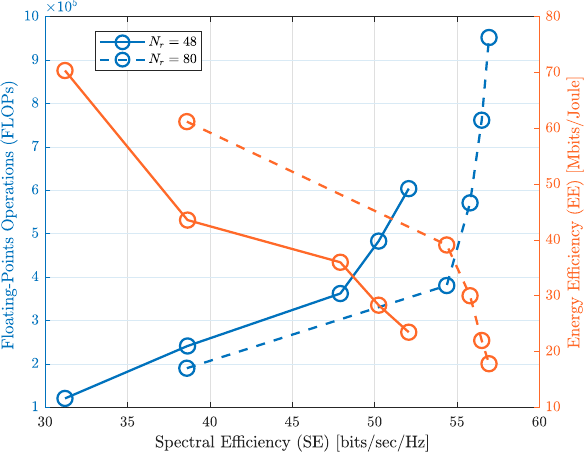
Figure 10. EE and SE and the complexity tradeoff as a function of the number M of APs when M = { 16,32,48,64,80 } , K = 8, ρ = 23 dBm, N Q = 8 CPSs, and N r = { 48,80 } for the proposed matching scheme in uplink cell-free mm-Wave massive MIMO